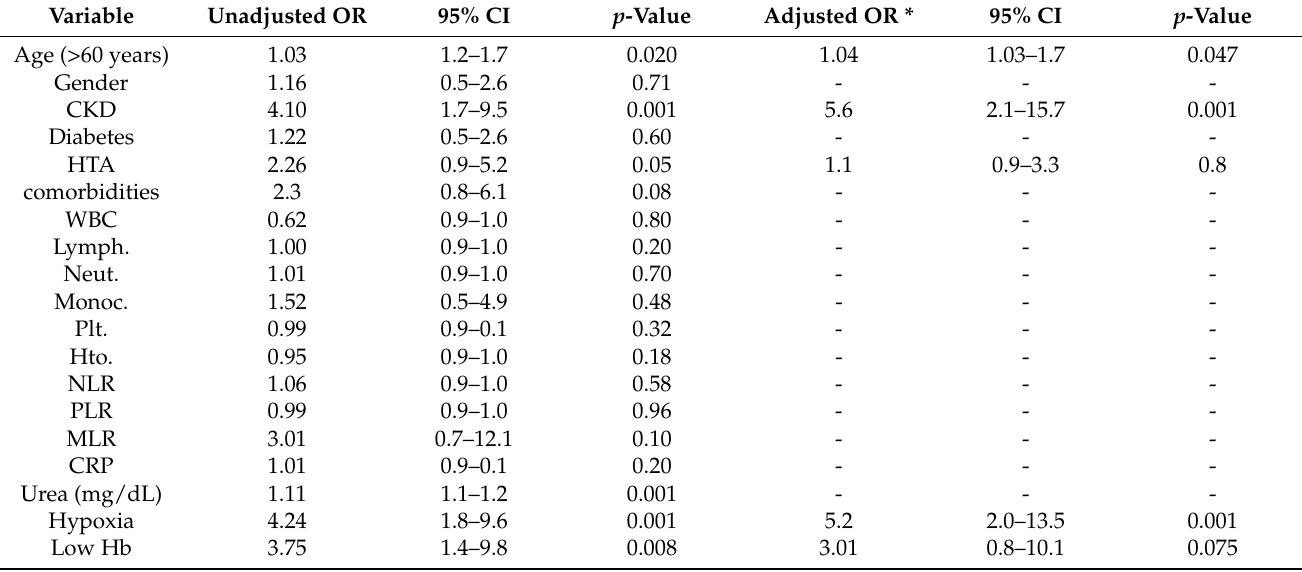
Table 4. Univariate logistic analysis and multivariate logistic